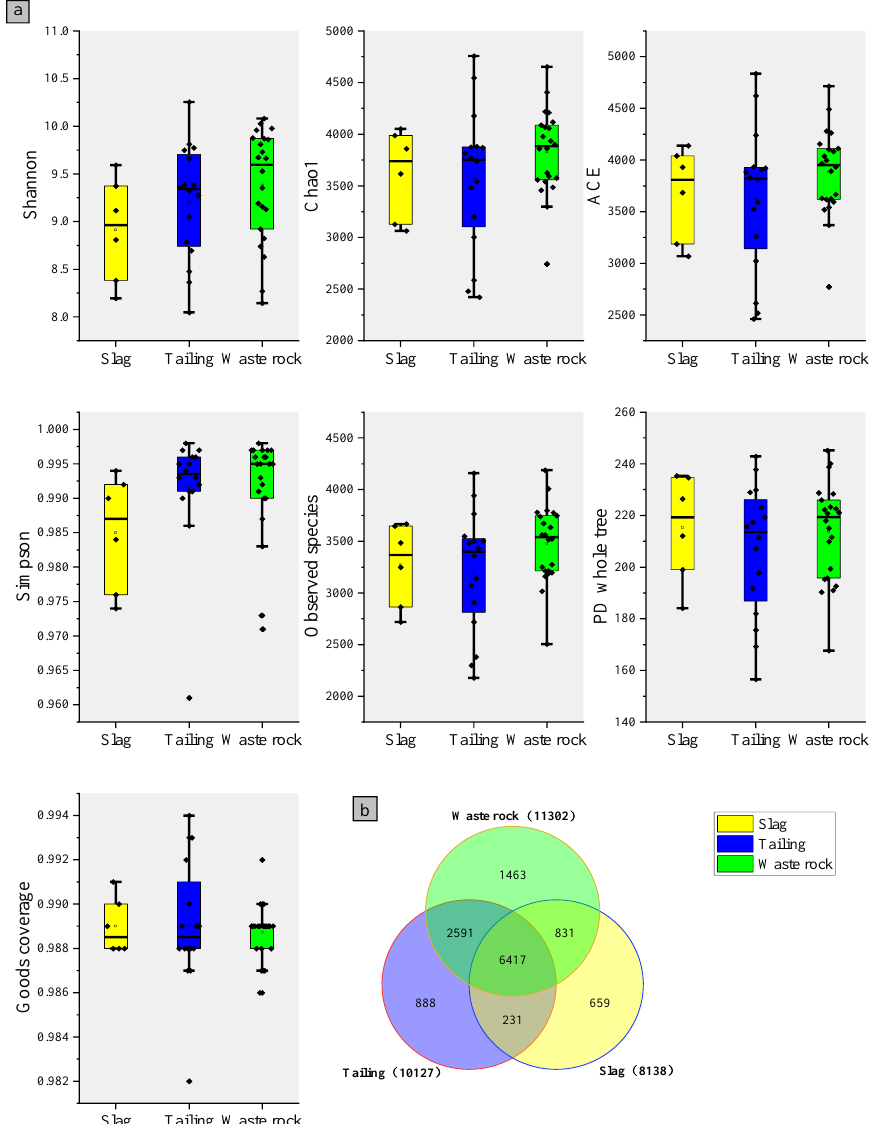
Figure 4. Rhizosphere microorganisms of three mine waste plants: ( a ) alpha diversity box plot and ( b ) OTUs number Venn plot.